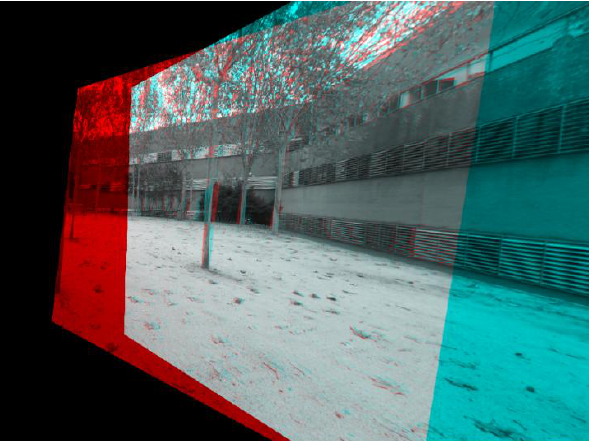
Figure 4. Stereo pair rectified and